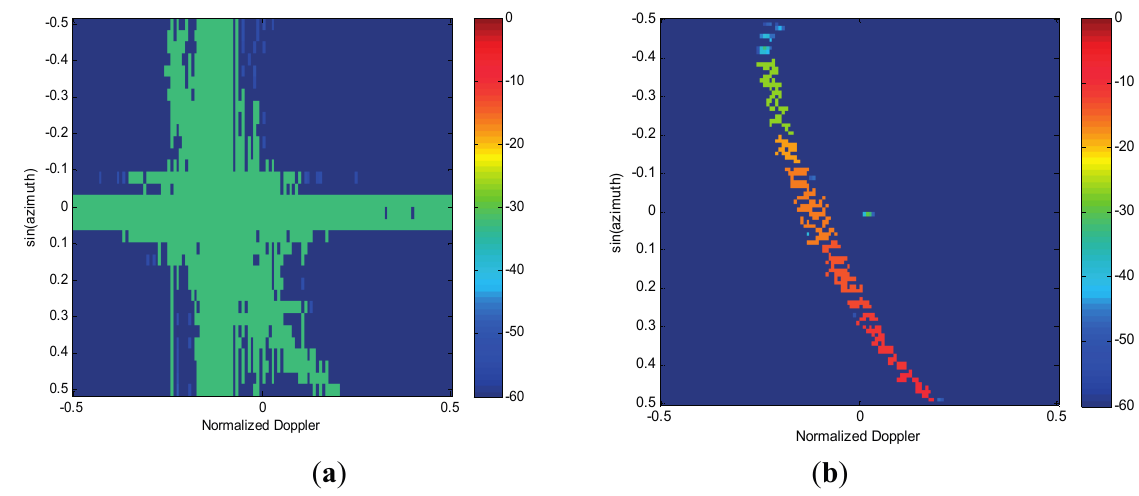
Figure 5. Feature extraction via RG algorithm. ( a ) 2D FFT. ( b ) RDSR.